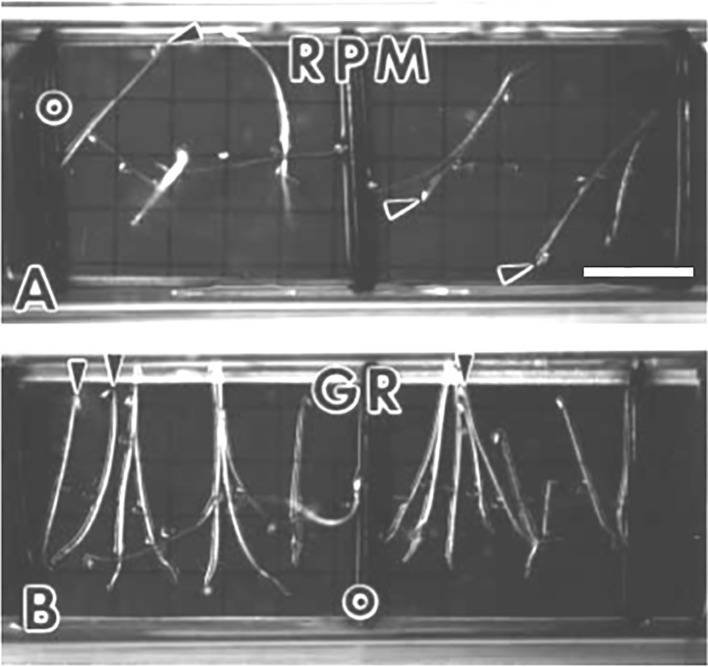

Arabidopsis seedlings grown in spaceflight hardware for 3.5 days in the dark. Arrowheads indicate the hypocotyl apex. (A) Seedlings that germinated and developed on the random positioning machine (RPM) are disoriented. (B) Ground controls (GR) are oriented to the gravity vector which is toward the bottom of the photograph. Scale bar, 6 mm. Figure is from Kraft et al. (2000) and is used with permission from Springer Nature publishers.